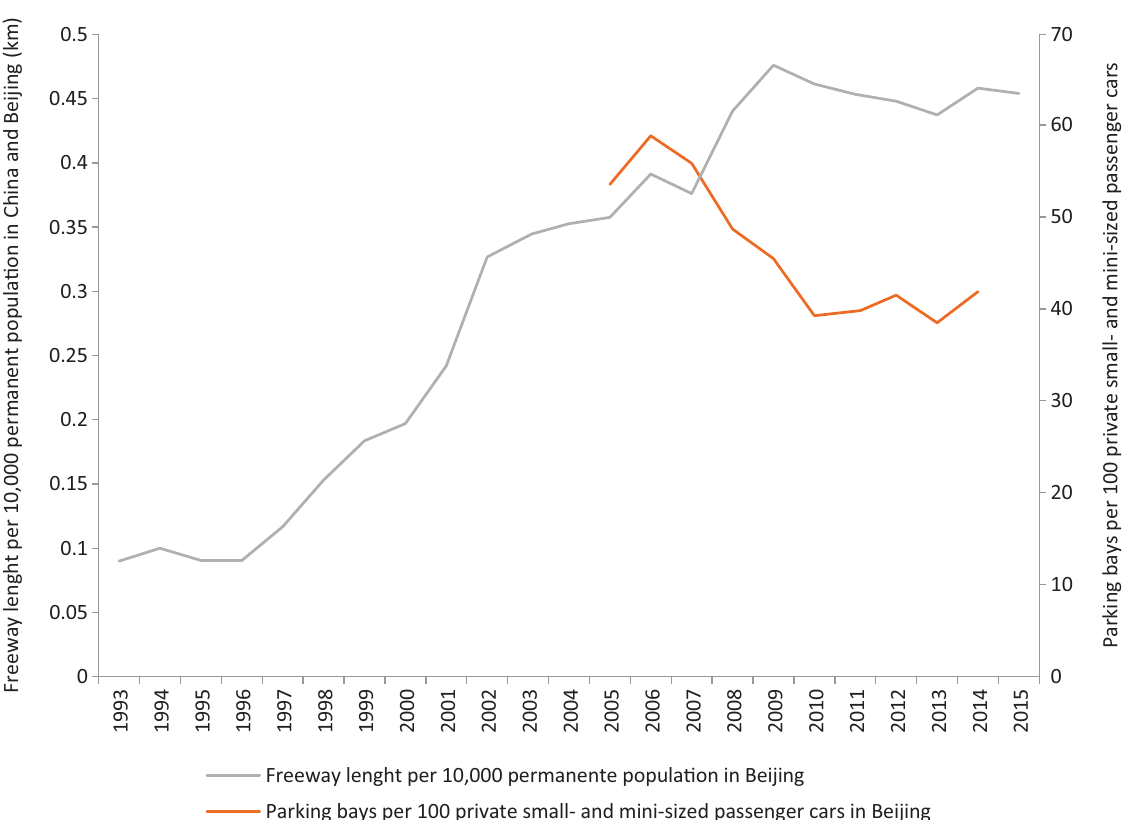
Figure 6. Trend of freeway length per 10,000 permanent population (km) and parking bays per 100 private small- and mini- sized passenger cars in Beijing. Source: Compiled based on data provided by the Beijing Transportation Research Centre (BJTRC, 2015) and (BJMBS, 1994–2015,